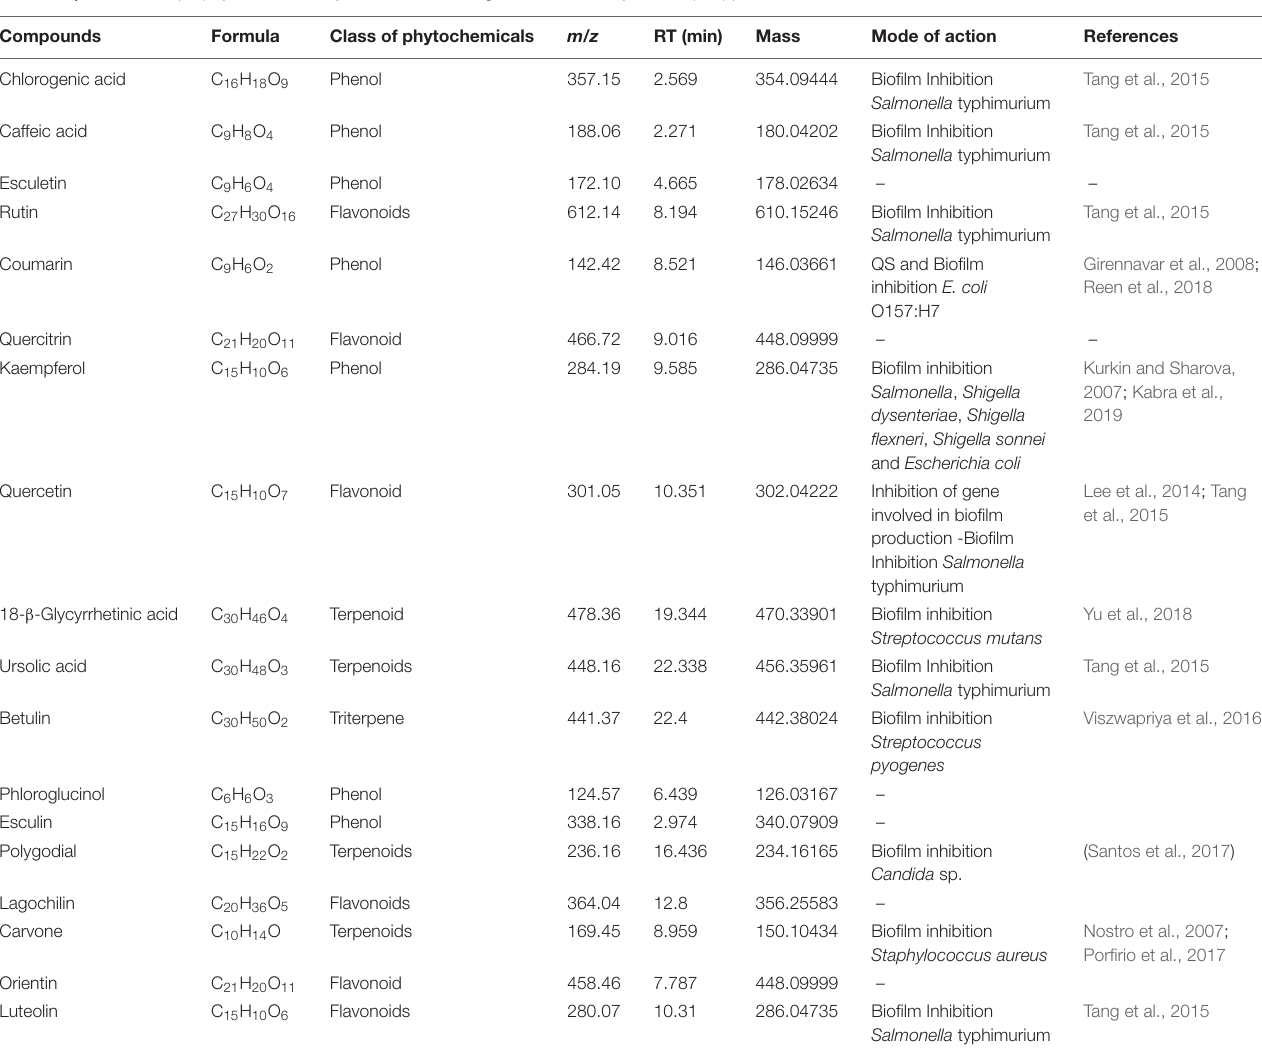
TABLE 4 | Identified major phytochemicals by HR-LCMS showing antibiofilm activity from A. philippense crude extract.